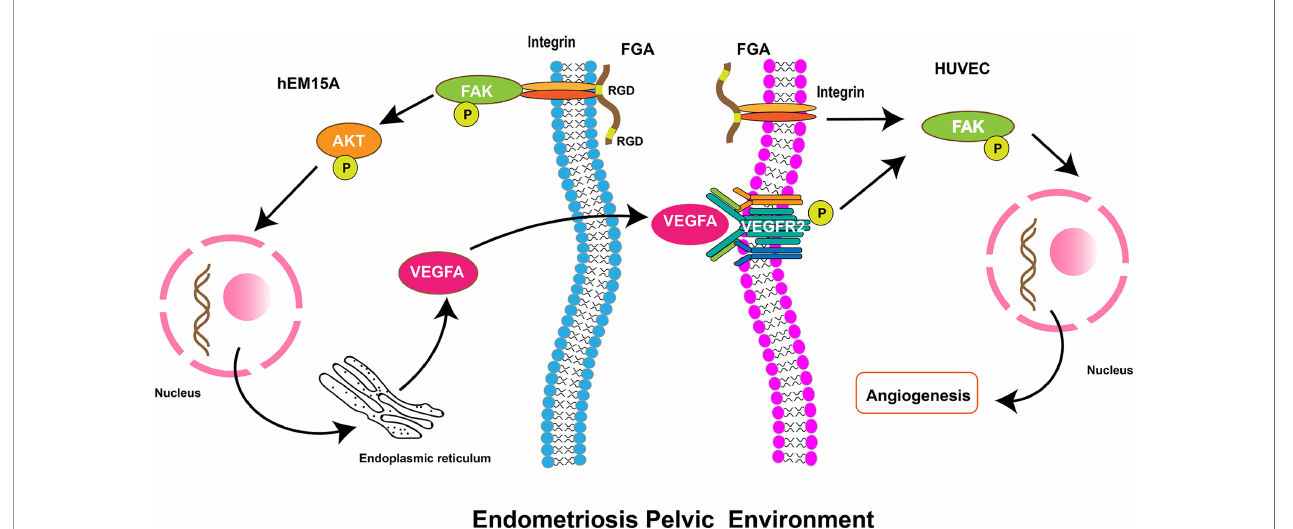
FIGURE 6 | Schematic diagram showing the role of FGA on angiogenesis in endometriosis. FGA in endometrial cells could activate the FAK-AKT signalling pathway by binding integrin via the RGD region and increase the expression of VEGFA. VEGFA from endometrial cells binds and phosphorylates its receptor, VEGFR, on endothelial cells and then activates the downstream FAK pathway to enhance